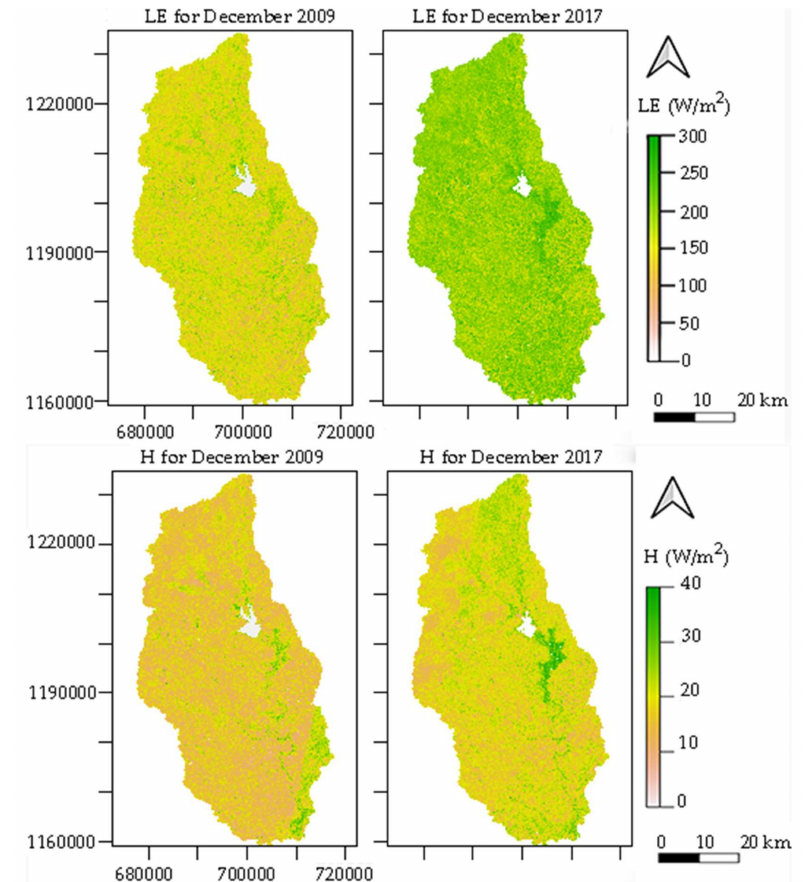
Figure 11. Latent heat flux (LE) and sensible heat flux (H) for December 2017 and